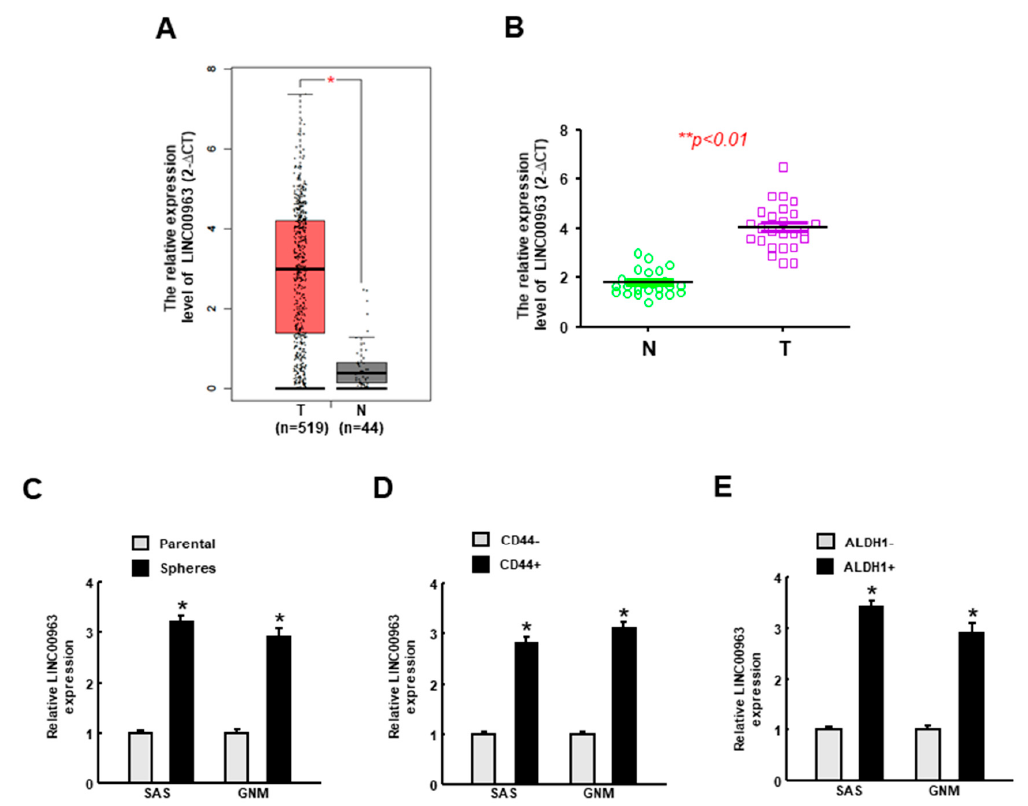
Figure 2. The expression of LINC00963 is upregulated in the oral cancer tissues and cancer stem cells. ( A ) Analysis of the expression level of LINC00963 in normal and oral squamous cell carcinoma (OSCC) tissues using TCGA dataset; ( B ) verification of the upregulated LINC00963 in OSCC tissues compared to normal counterparts ( n = 25 for each group) using RT-PCR analysis; expression of LINC00963 in spheroid ( C ), CD44 + ( D ), and ALDH1 + ( E ) cells were evaluated by RT-PCR. Experiments were repeated three times and representative results were shown. Results are means ± SD of triplicate samples from three experiments. * p < 0.05